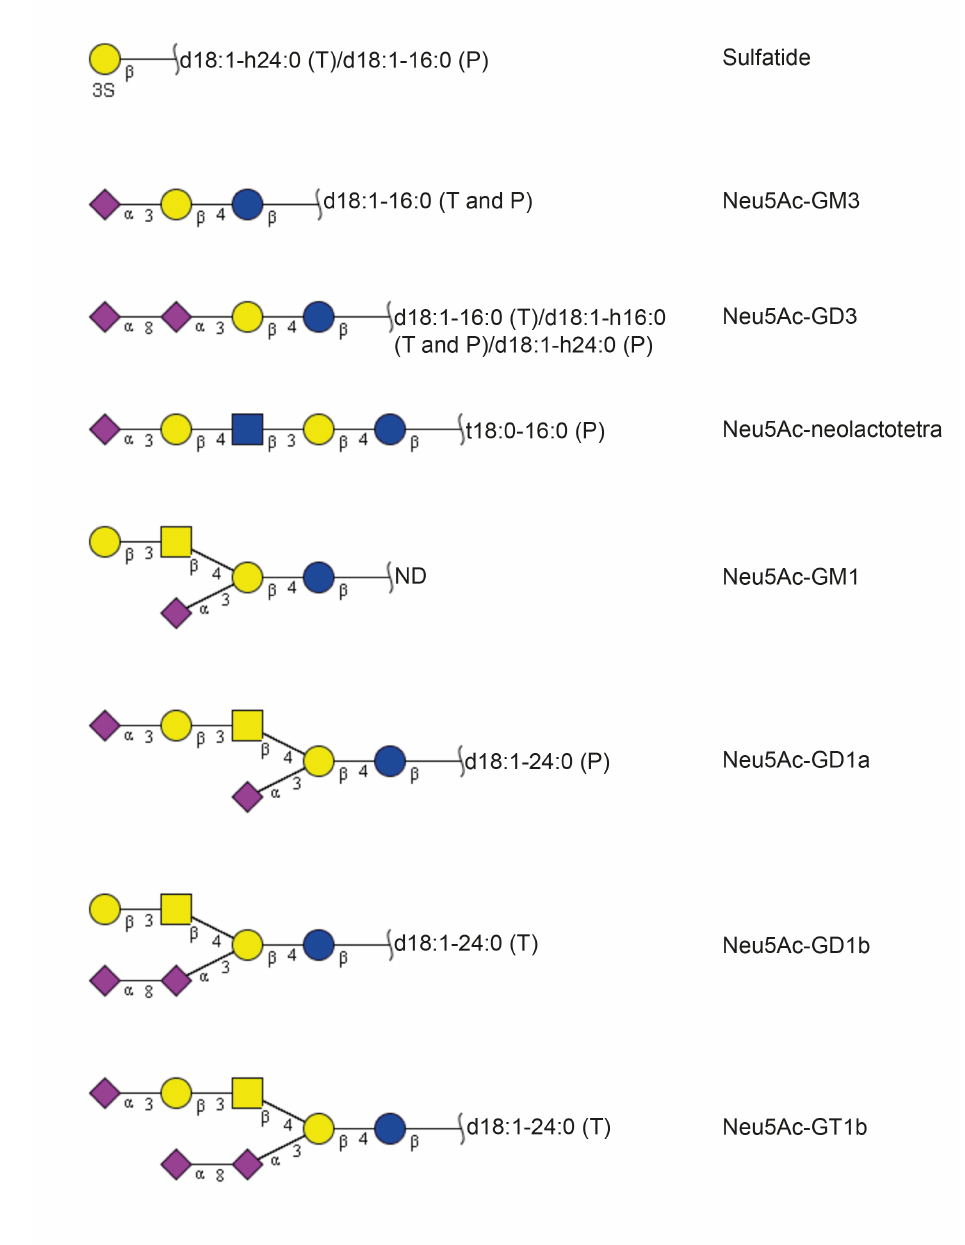
Figure 9. Summary of the acid glycosphingolipids from human thyroid and parathyroid glands. The proposed structures are depicted using the Symbol Nomenclature for Glycomics (SNFG) [12,13]. In the shorthand nomenclature for fatty acids and bases, the number before the colon refers to the